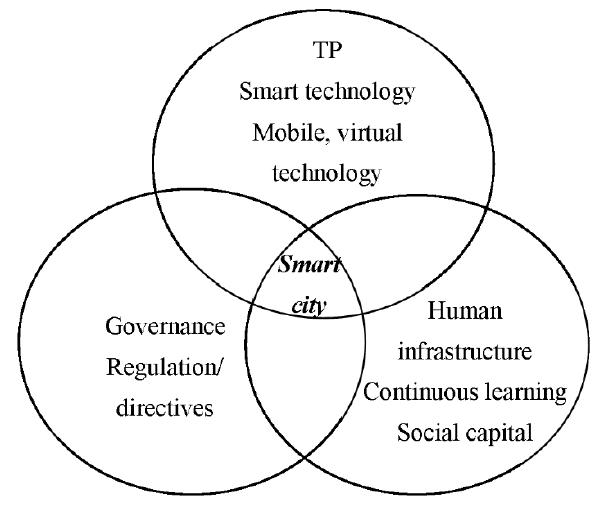
Figure 1. Performance parameters of smart cities.